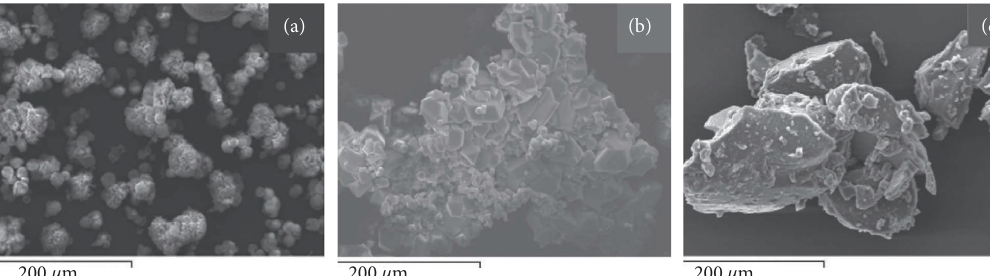
Figure 27: SEM photograph of (a) Zeolite, (b) [Zn 3 (BTC) 2 ] and (c) Zeolite@[Zn 3 (BTC) 2 ] adopted from from [33].